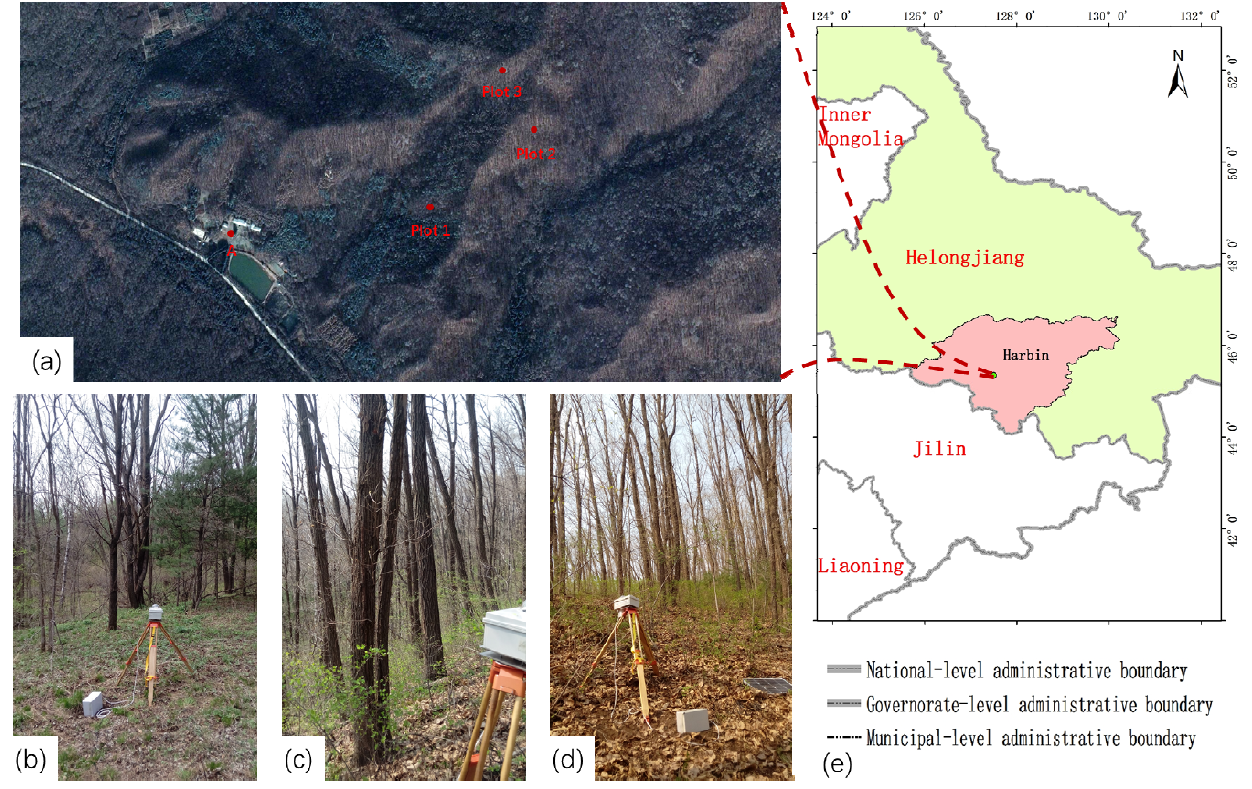
Figure 2. Study area: ( a ) remote sensing image of Ecosystem Research Station area in Maoershan Experimental Forest Farm; ( b – d ) field photos of Plots 1–3; ( e ) Maoershan Experimental Forest Farm of Northeast Forestry University in northeastern China. The A point stands for the place where the above-canopy value of an open field was measured. Table 1. General characteristics and species composition of the three deciduous broadleaf forest plots.